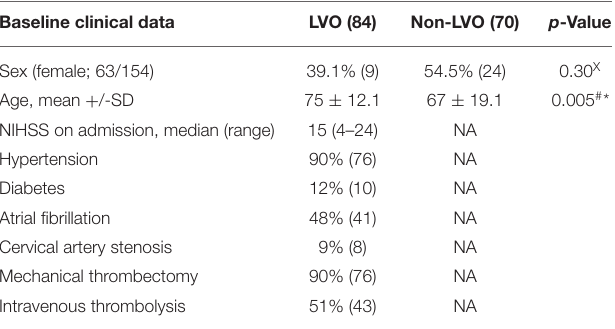
TABLE 1 | Demographic and clinical